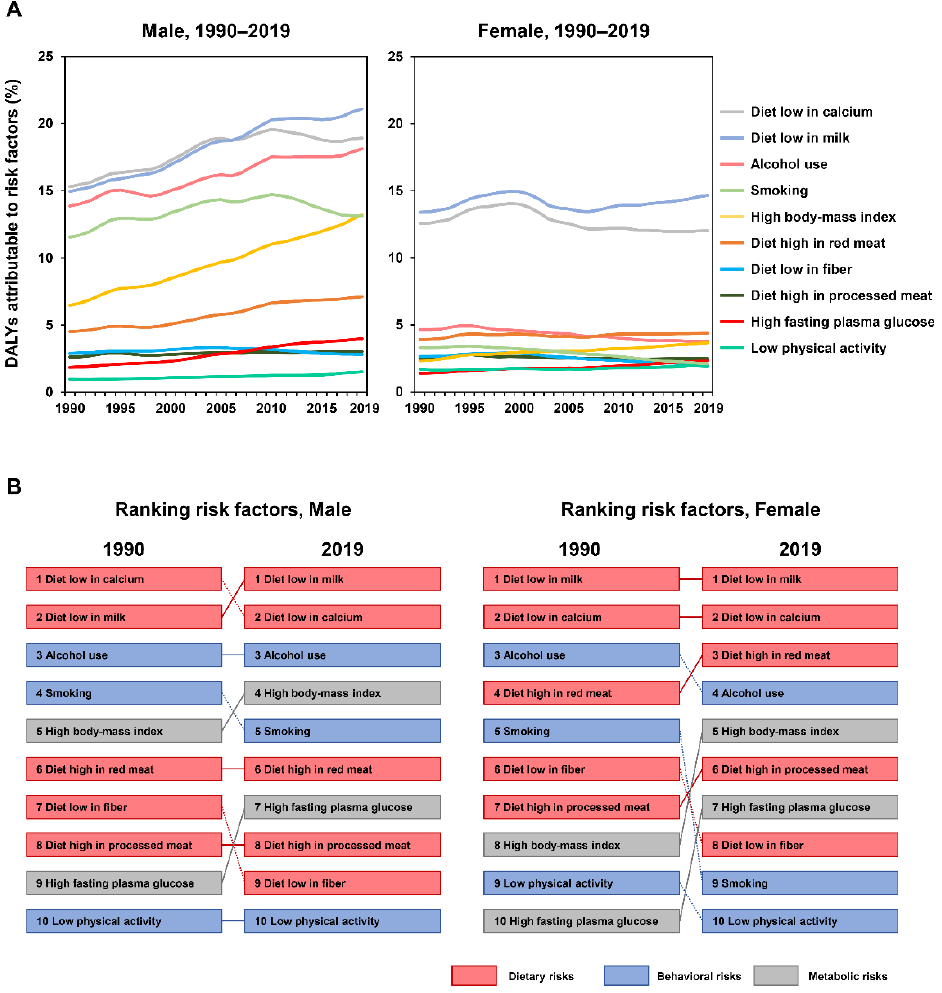
Figure 6. ( A ) The trends of early-onset CRC DALYs compared to risk factors by sex, 1990–2019. ( B ) Comparison of the rankings of early-onset CRC DALYs to risk factors in 1990 and 2019 by sex. CRC: colorectal cancer; DALY: disability-adjusted life-year.